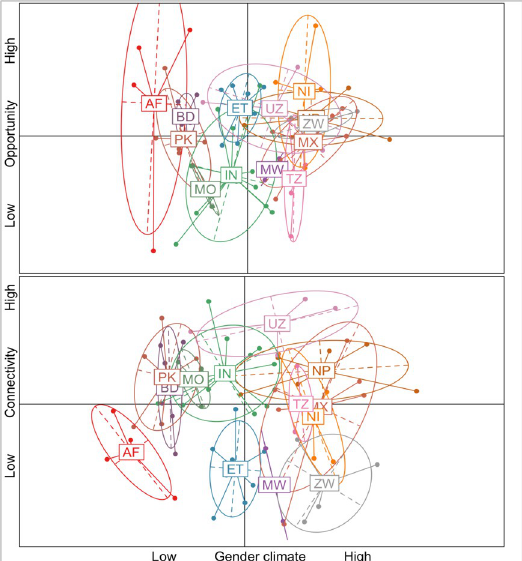
Fig 4. Visualization of relation between components grouped by country cohort. The scores of the villages are grouped by country cohort (two letter code). ‘Gender climate’ is in x-axis, while the two complementary components, ‘Opportunity’ and ‘Connectivity’, are represented in